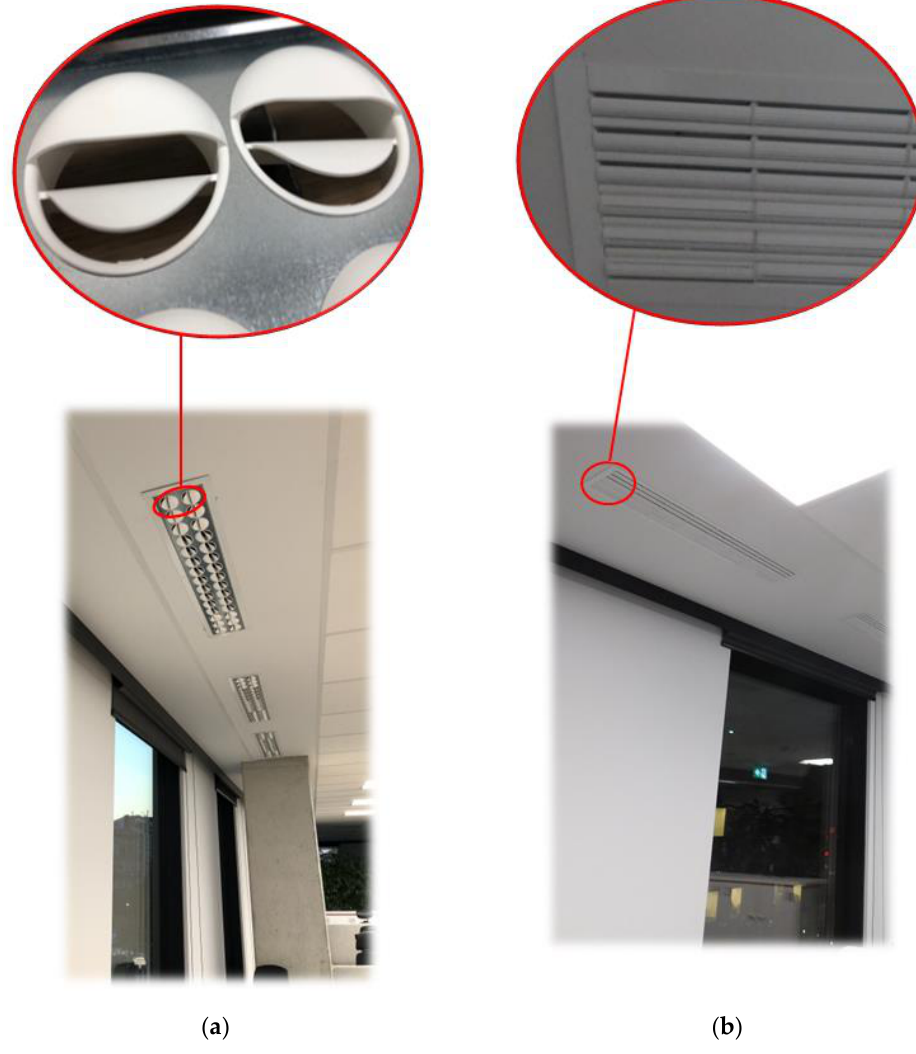
Figure 2. Linear diffuser: ( a ) Type I; ( b ) Type